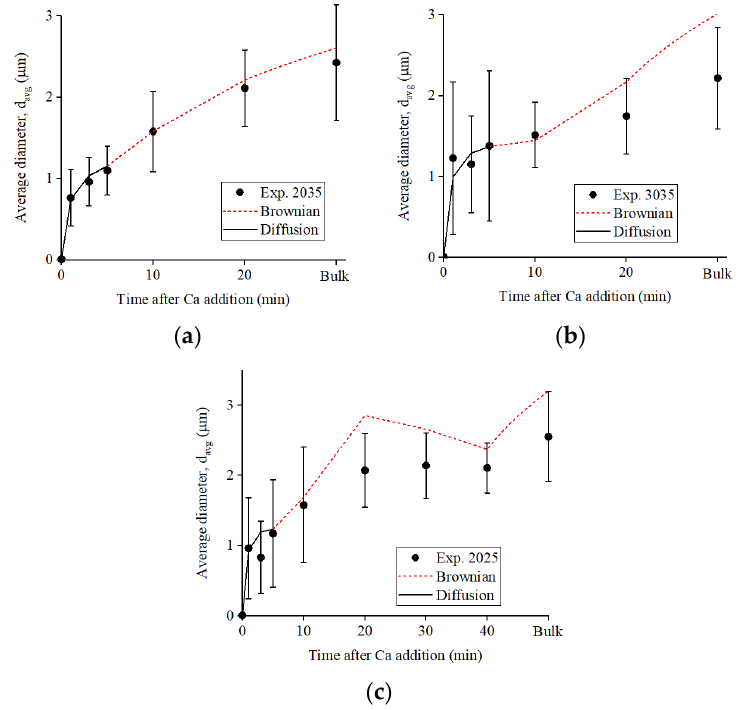
Figure 10. Comparison of the average diameters of CaS type inclusions in samples taken from ( a ) Exp. 2035, ( b ) Exp. 3035, and ( c ) Exp. 2025, and predicted based on diffusion-controlled growth followed by Brownian motion.